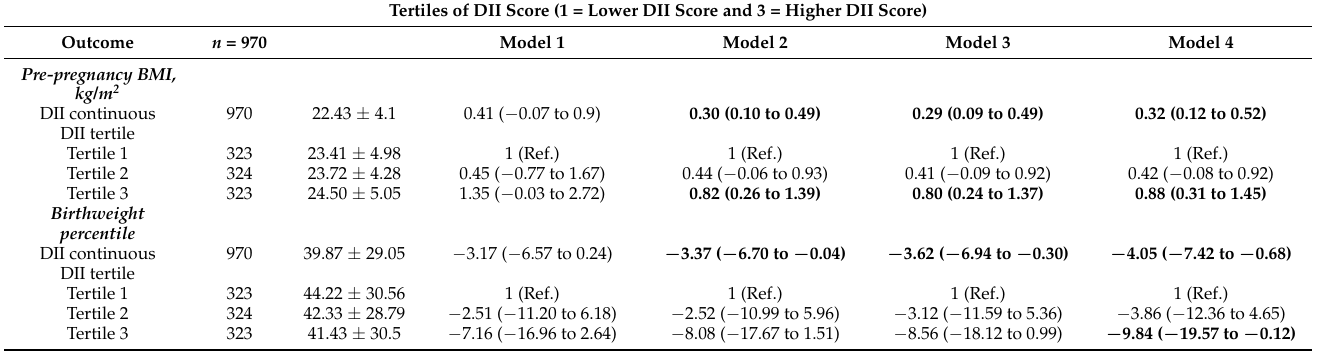
Table 4. Association between DII score (per unit and tertile) and pre-pregnancy BMI and newborn